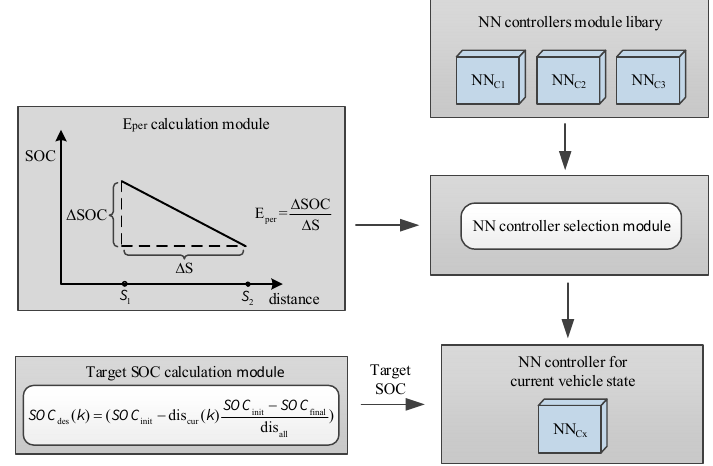
Figure 10. Detailed operation flowchart of intelligent energy management controller for EREV based on dynamic programming and neural networks